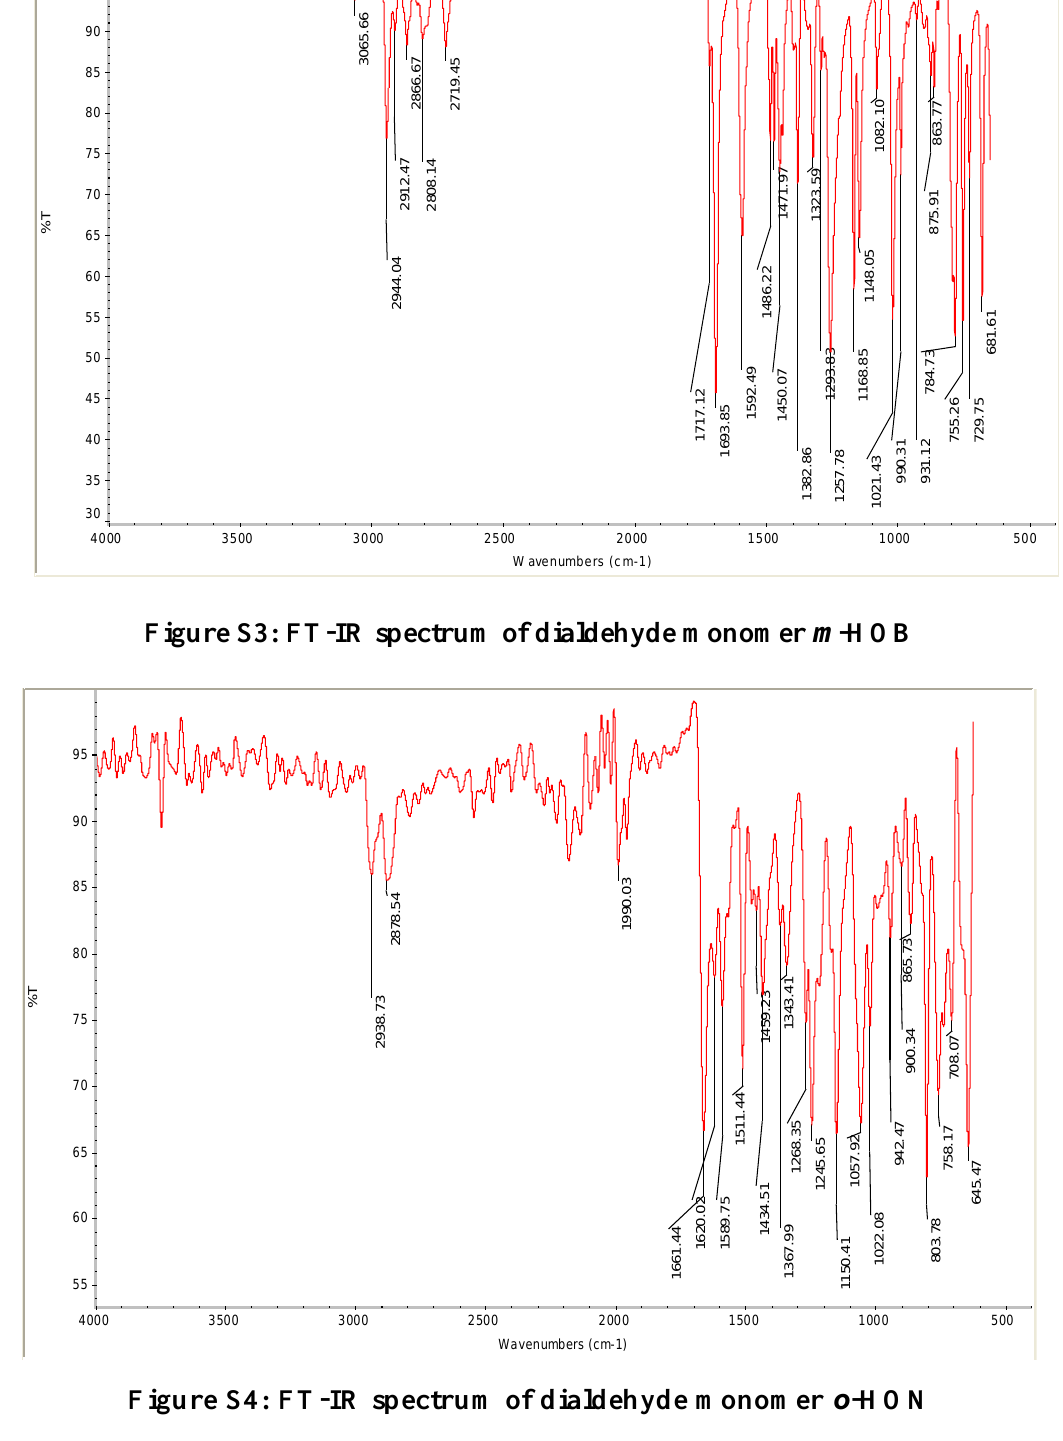
Figure S4: FT-IR spectrum of dialdehyde monomer o